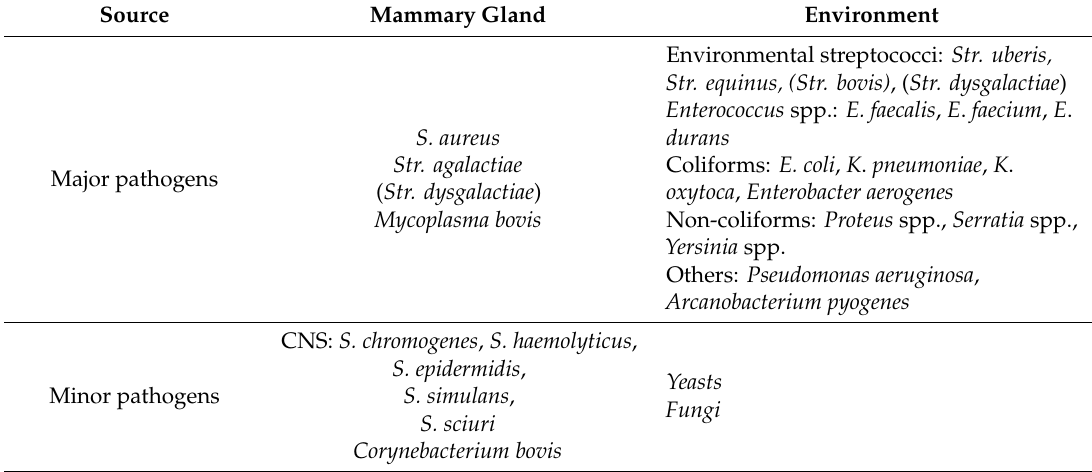
Table 2. Classification of mastitis-causing